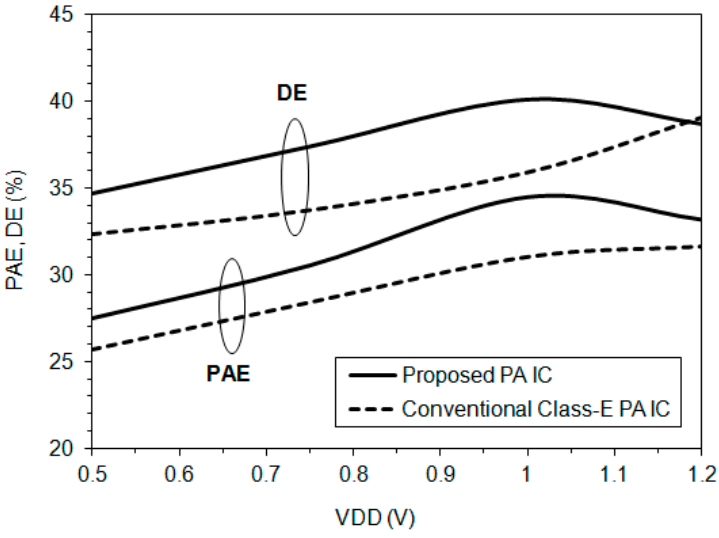
Figure 16. The drain efficiency (DE) and PAE of the proposed PA (solid line) and the conventional class-E PA (dotted line) versus the supply voltage.